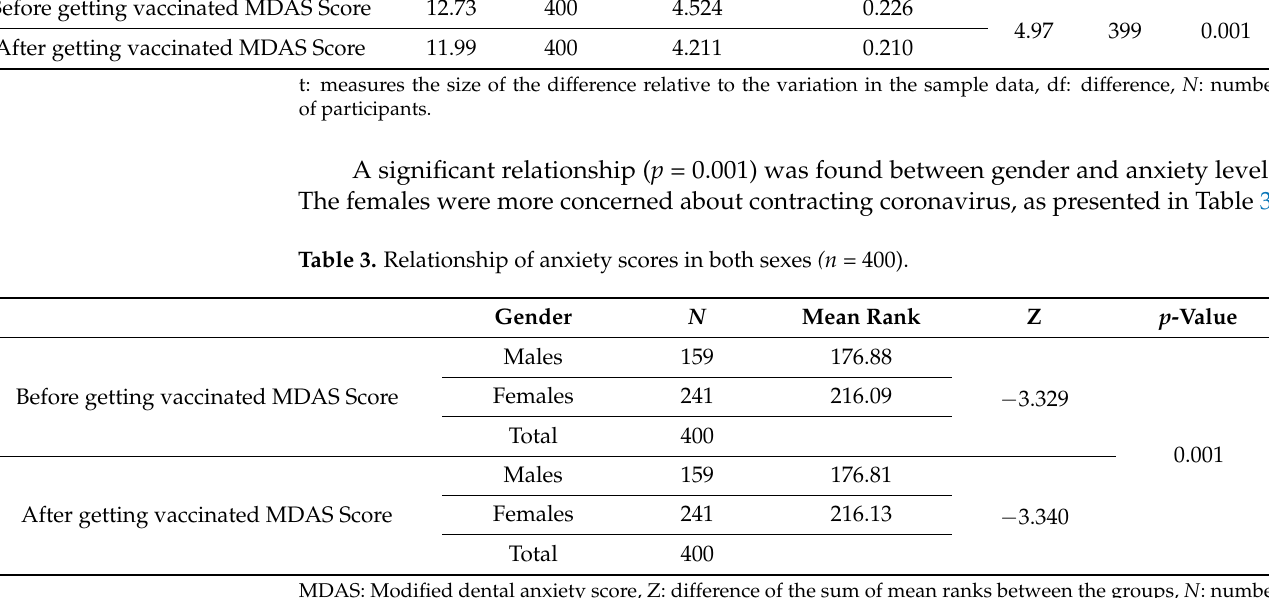
Table 2. Comparison of mean MDAS scores before and after getting vaccinated. Std. Error Mean N Std. Deviation